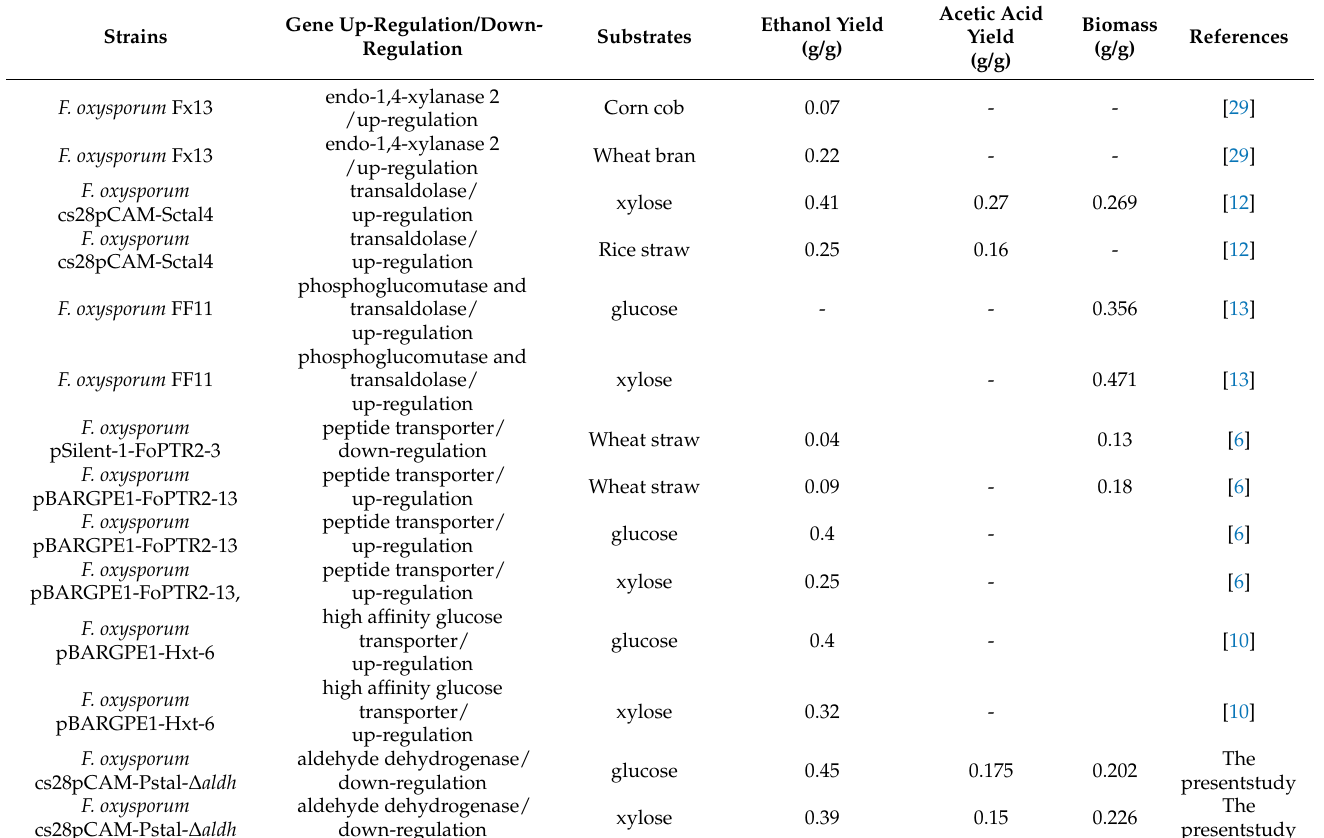
Table 4. Review of ethanol yield of different genetically modified Fusarium oxysporum strains and their fermentative performance in this study and from the